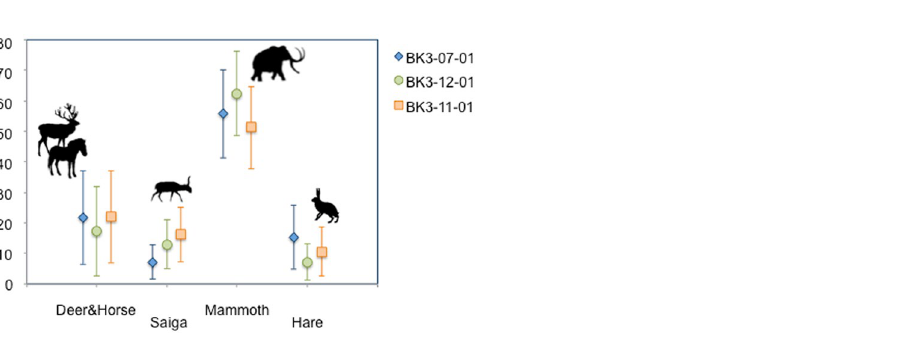
Figure 5. Proportional contribution of Deer&Horse (red deer and horse), Saiga (saiga antelope), Mammoth (woolly mammoth) and Hare (hare) as estimated by SIAR model for human remains from Buran-Kaya III layers 6-2 and 6-1. Each symbol corresponds to the mean protein diet contribution to a given human individual. Bars indicate standard